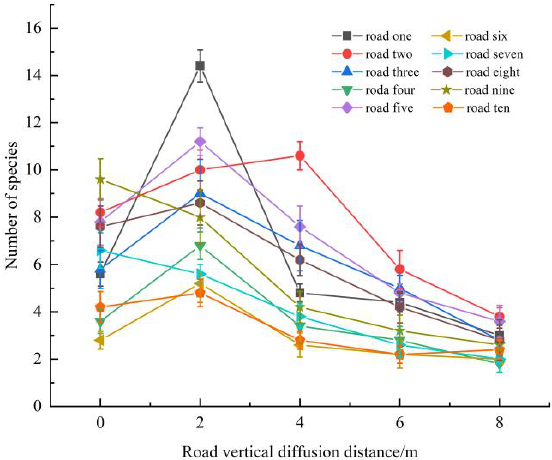
Figure 7. Diffusion pattern of IAS on both sides of roads.